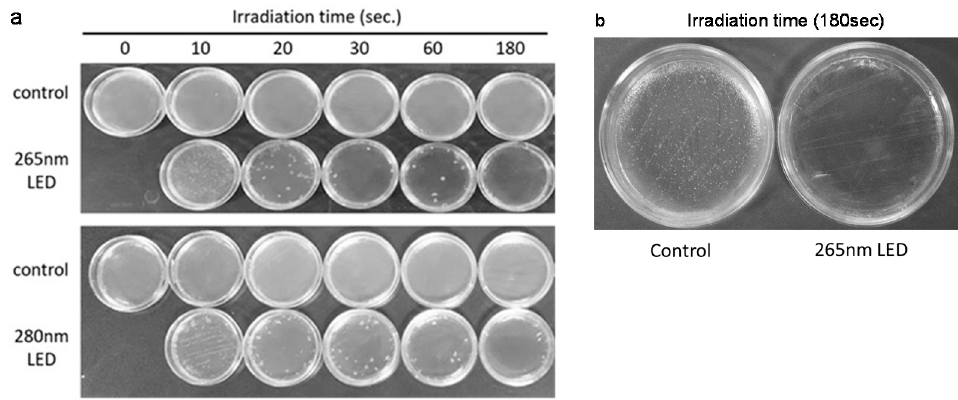
Figure 3. Qualitative test of the bactericidal effect of DUV-LED light irradiation on Fusobacterium nucleatum . ( a ) The growth of colonies of F. nucleatum was observed after irradiation with 265 nm LED and 280 nm LED at each time point. A non-irradiated control was used. ( b ) An enlarged image of the agar plates.